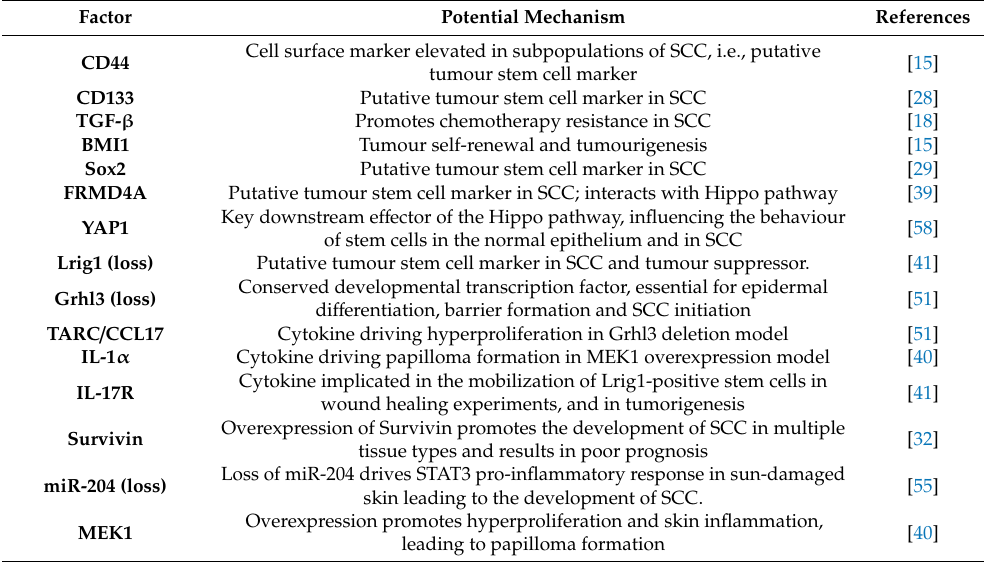
Table 1. Summary of factors that are shown to regulate tumour-initiating cell growth in cutaneous